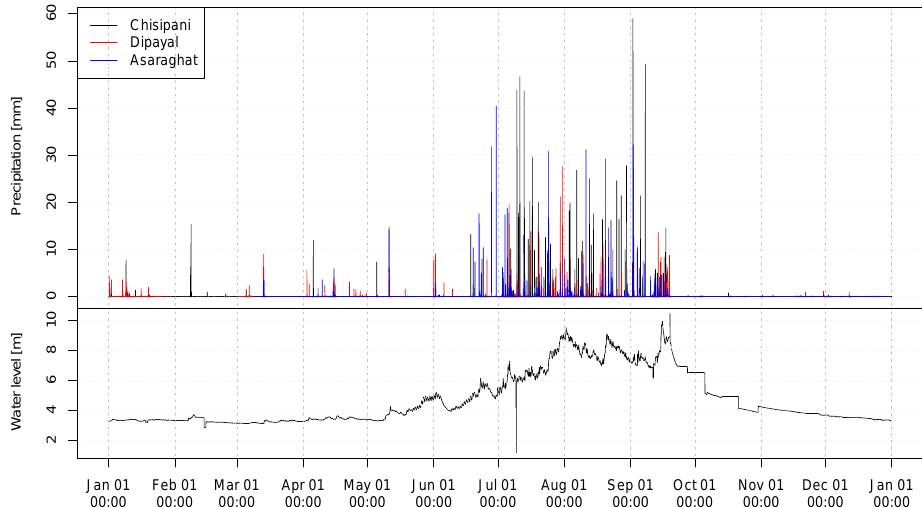
Figure 3. An example year of data for the Karnali River basin showing the observed water level at Chisapani (lower pane) and rainfall recorded at the three gauges (Chisapani, Dipayal and Asaraghat). Note the spatial variability in the rainfall and, even in this comparatively dry monsoon, the river range of approximately